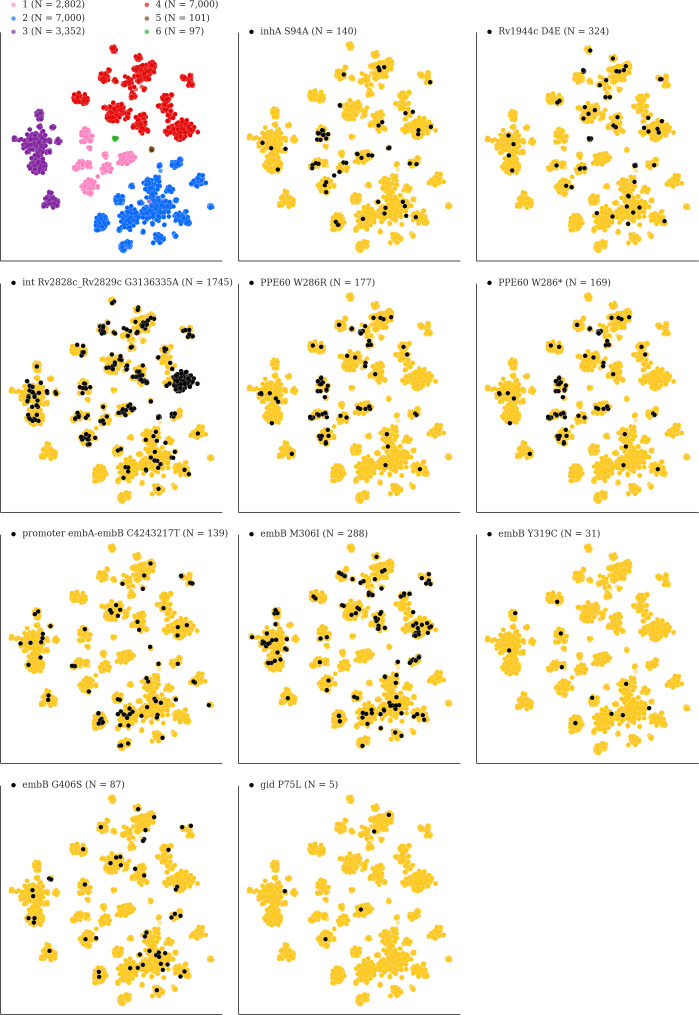
Mutations acquired in-host are phylogenetically convergent.We constructed t-SNE plots from a pairwise SNP distance matrix for our global sample of 20,352 clinical isolates and 128,898 SNP sites (Materials and methods). Isolates are colored by global lineage in the first plot, the rest are colored by whether isolates had specific mutations in that were detected in-host (Supplementary file 8). These mutations occur in a global collection of isolates (Supplementary file 18) and are scattered across the tSNE plots, indicating that they belong to genetically different clusters of isolates (Supplementary file 19) and have arisen independently in different genetic backgrounds. Each plot is labeled with the gene name each mutation occurs within, amino acid encoded by the reference allele, H37Rv codon position, and amino acid encoded by the mutant allele (for intergenic mutations - reference allele, H37Rv genome coordinate, and mutant allele). N = number of isolates with mutant allele.